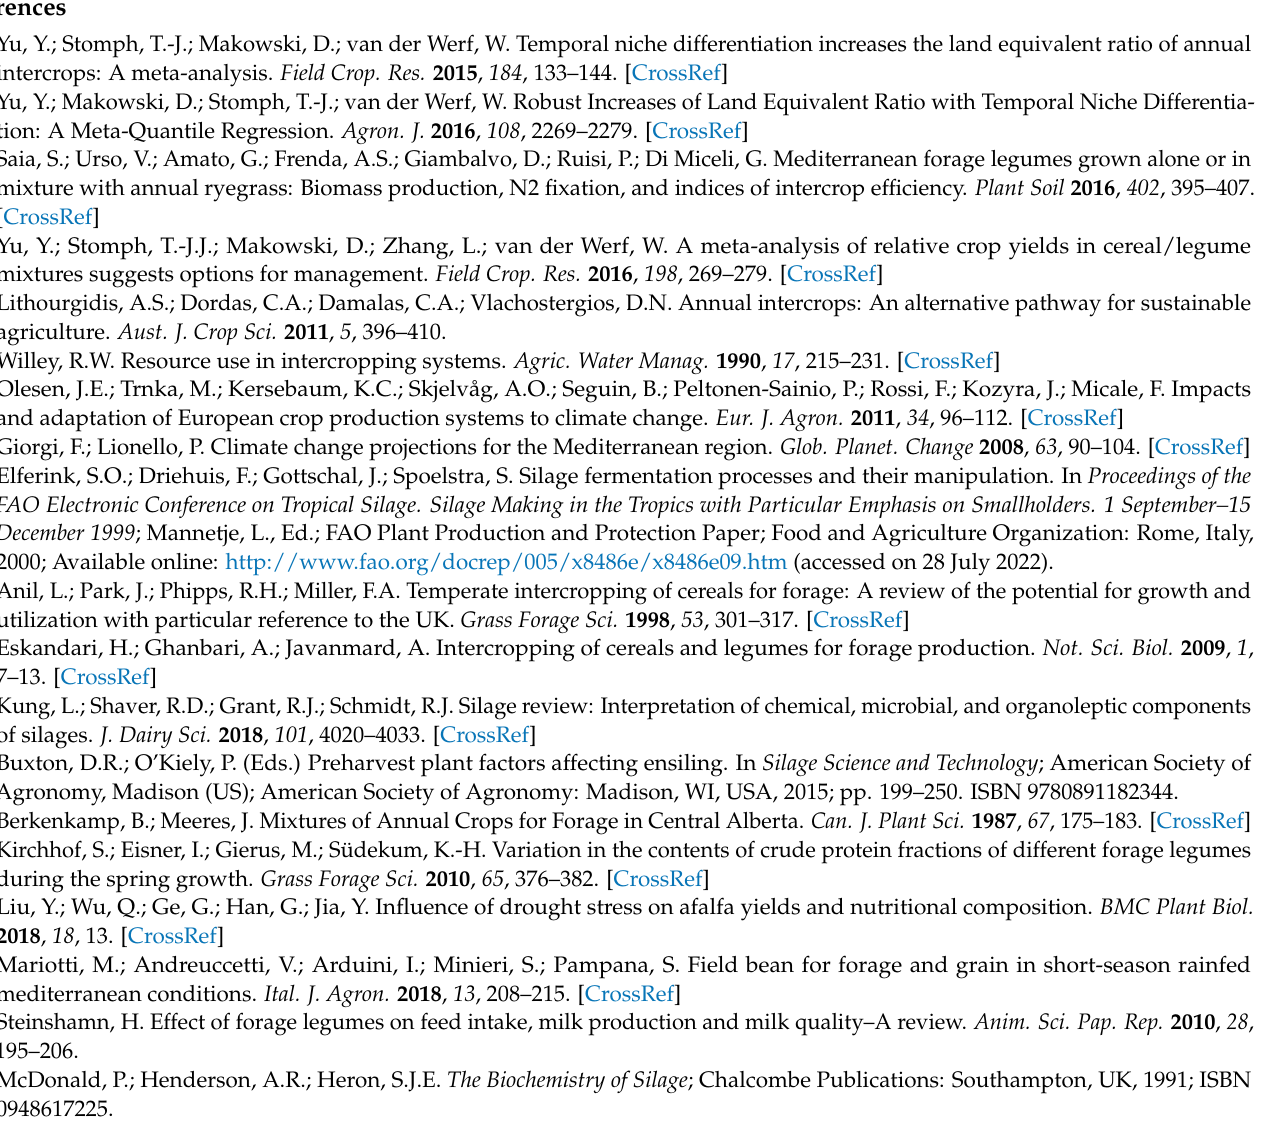
Cellulose concentration of the silage; Figure S27: Hemicellulose concentration of the silage. File S1: Raw Results of the Statistical